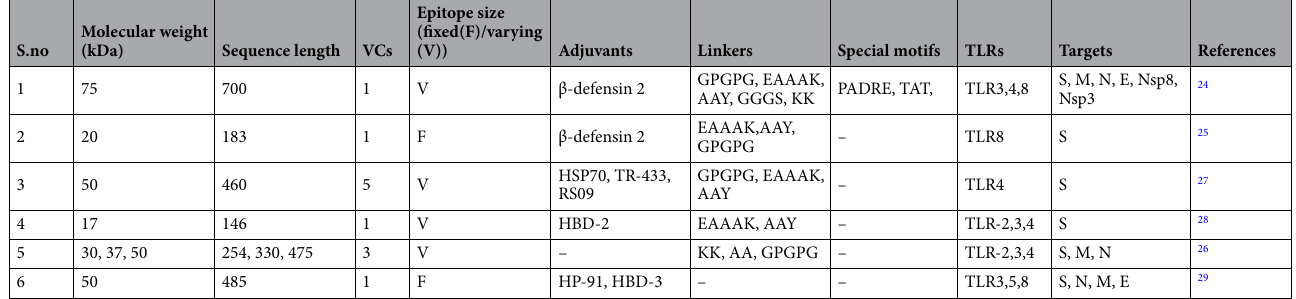
Table 1. The common components, i.e., adjuvants, linkers and predicted epitopes specific to various targets of SARS-CoV-2 are used in a MEBPV construction. The data provides the components which are commonly used in the design of MEBPVCs with relevant